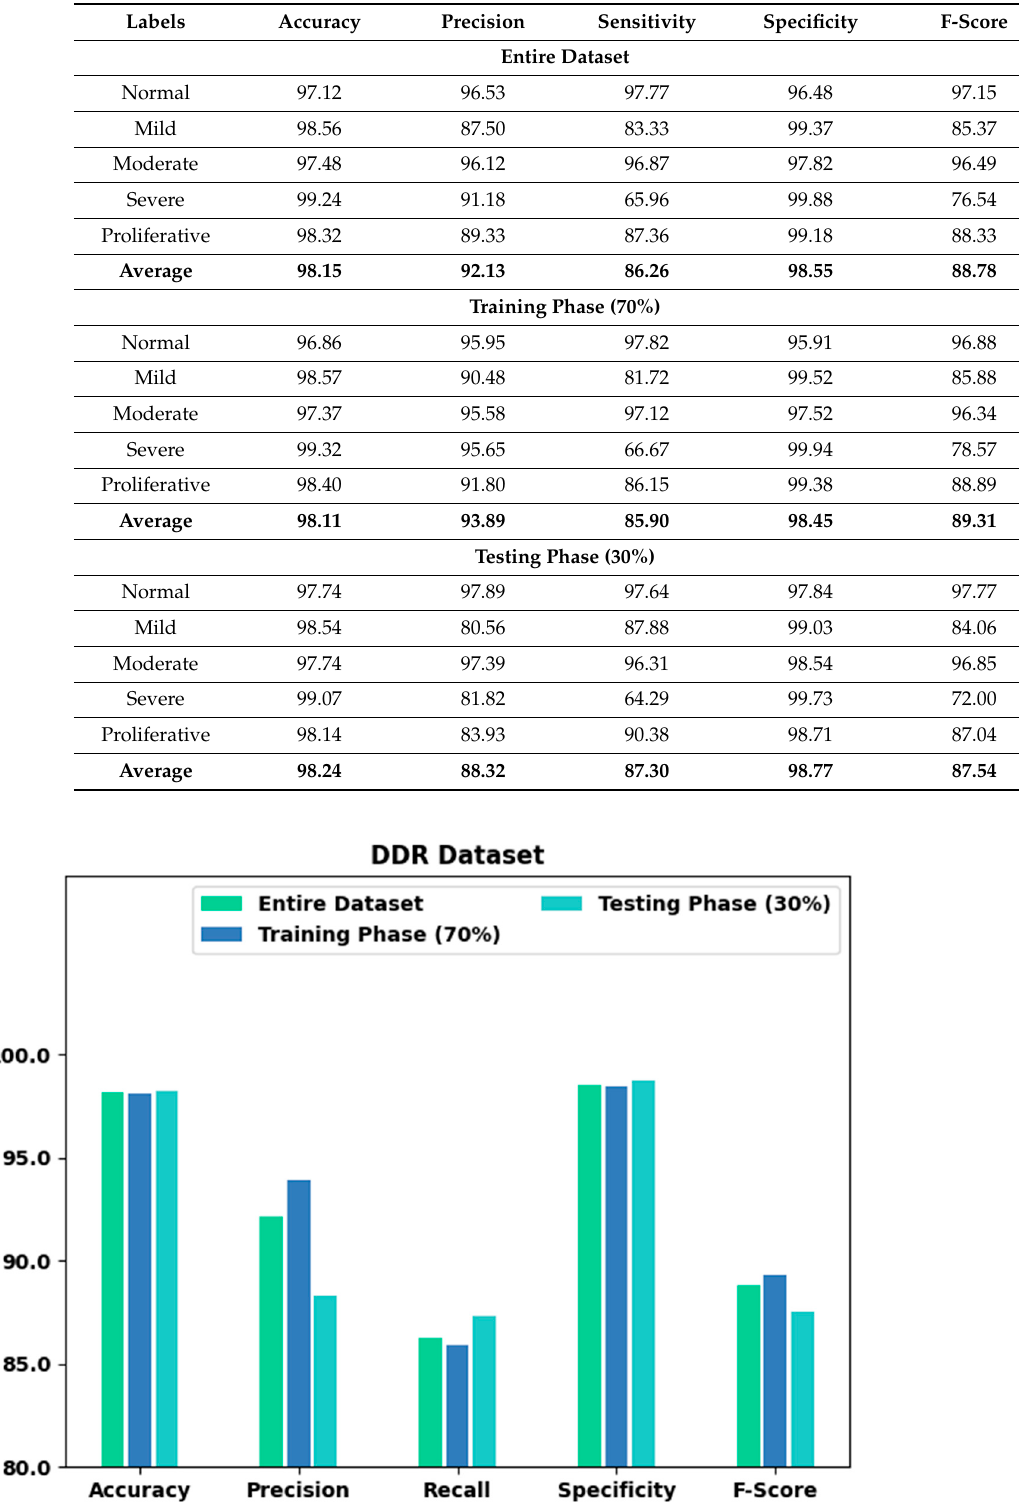
Figure 9. Result analysis of the XAITO-DRGC approach under the DDR dataset.